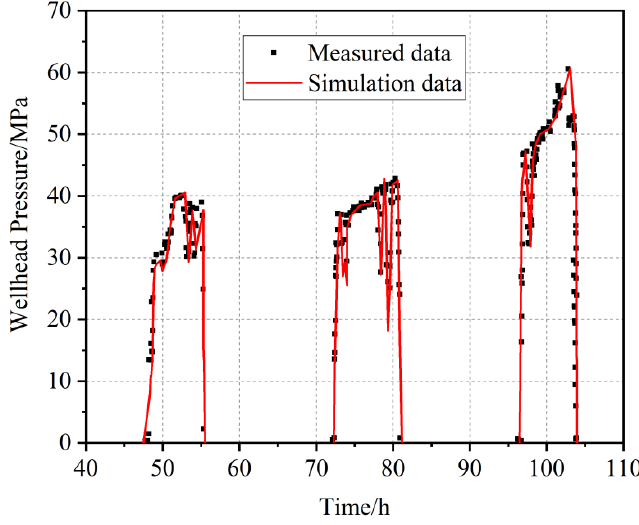
Figure 7. Comparison of measured and simulated results of reservoir stimulation in the second stage.